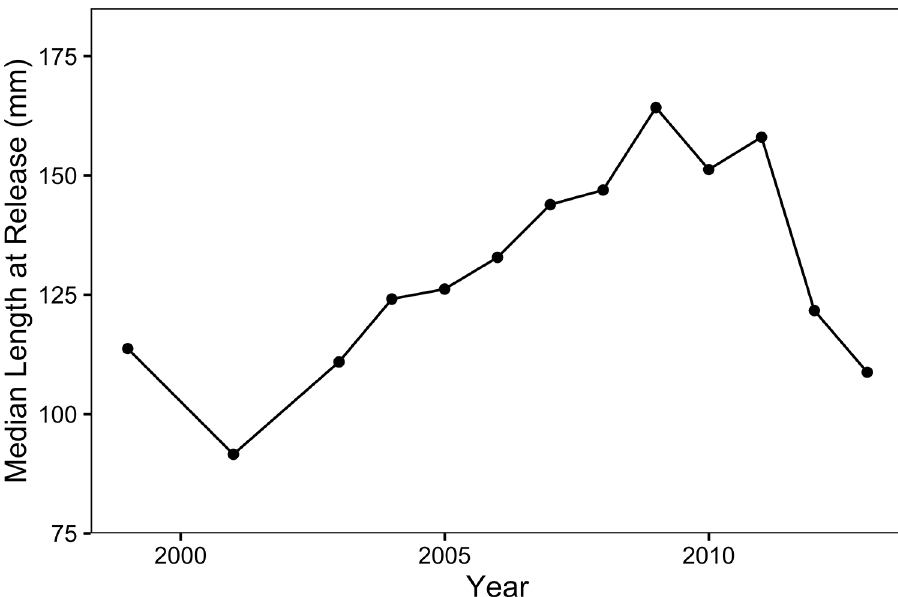
Fig 7. Median lengths of steelhead at the time of releasefrom captive-rearing. A changein feeding practices at the rearing facility, emphasizing abundantkrill to reducecannibalismamong O . mykiss , substantially increasedthe size of released fish over the course of the study. Declinesin release size after 2011 were probablydue to poorer rearingconditionsin the facility and early releases,both occasionedby drought effects on operations.